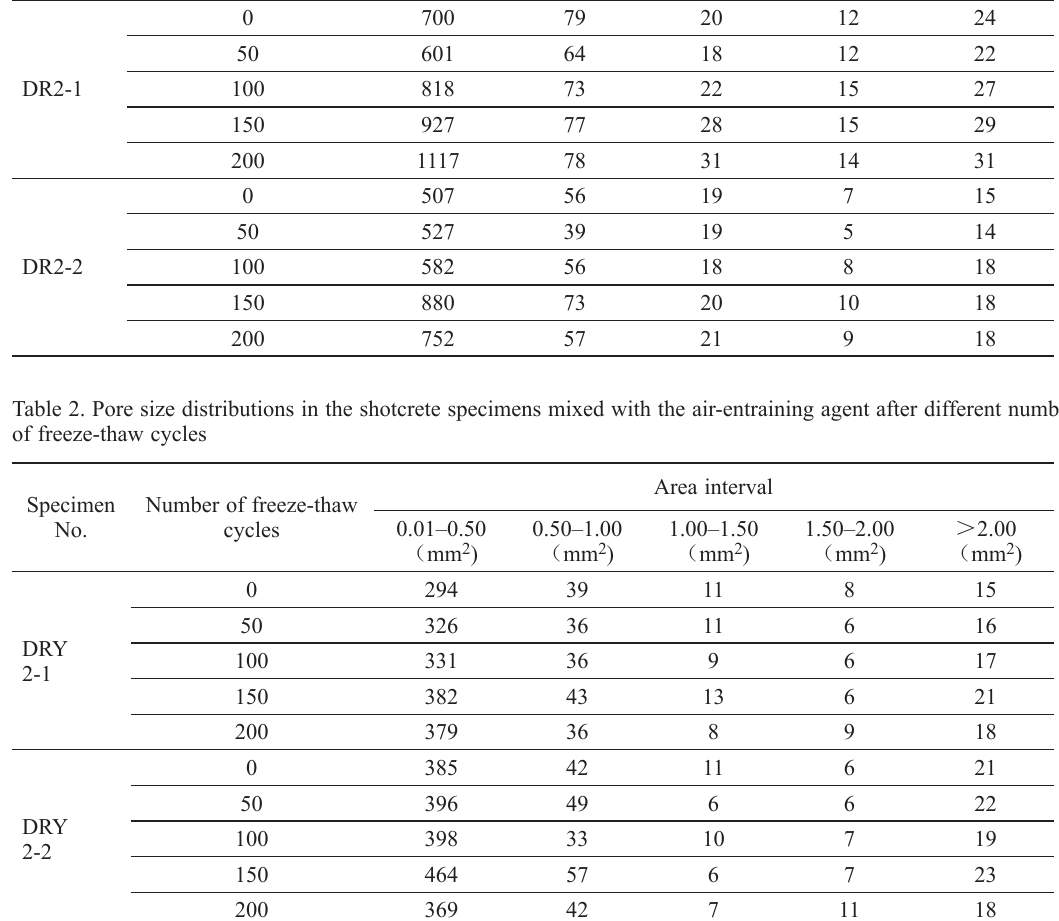
Table 1. Pore size distributions in the ordinary shotcrete specimens after different numbers of freeze-thaw cycles Specimen No.